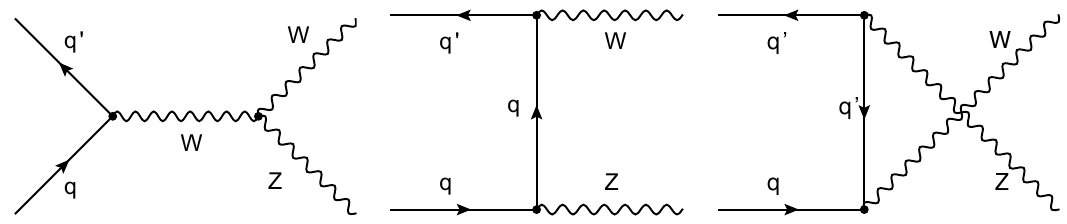
Figure 1 . Feynman diagrams for WZ production at leading order in perturbative QCD in proton- proton collisions for the s -channel (left), t -channel (middle), and u -channel (right). The contribution from s -channel proceeds through